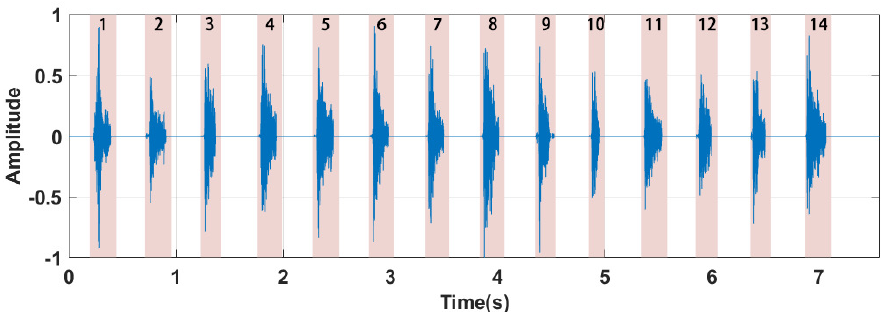
Figure 6. Separation